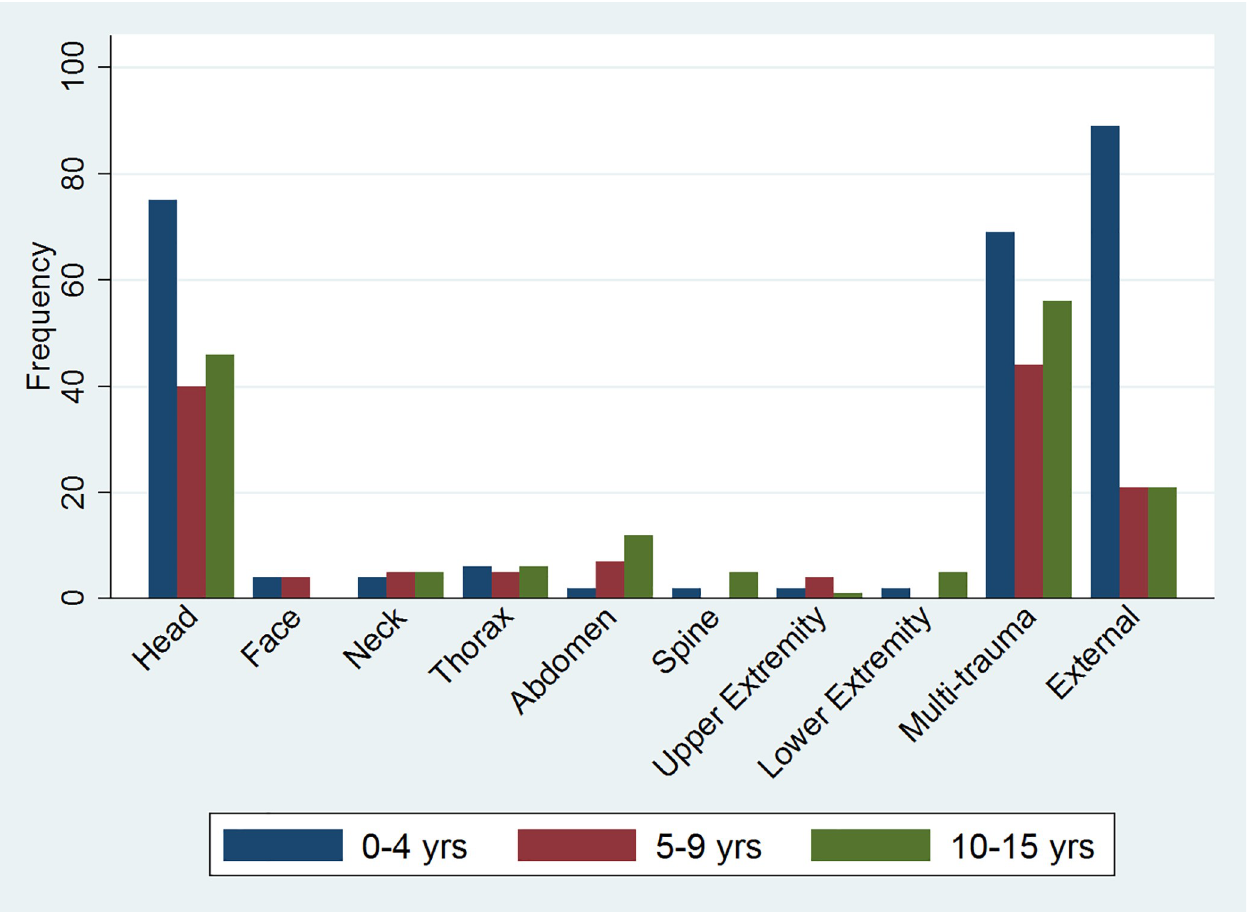
Fig 1. Trauma by body region in demographic groups‡. ‡ (external = burns, drowning, asphyxia and electrical injuries).